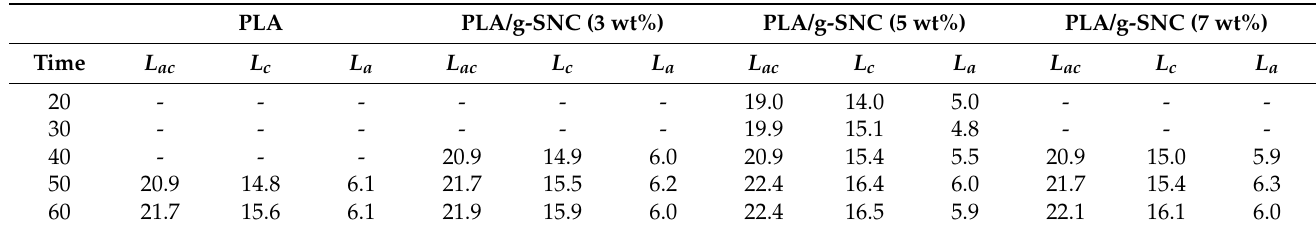
Table 2. SAXS data of PLA and PLA/g-SNC nanocomposite which are crystallized at 130 ◦ C and at various crystallization